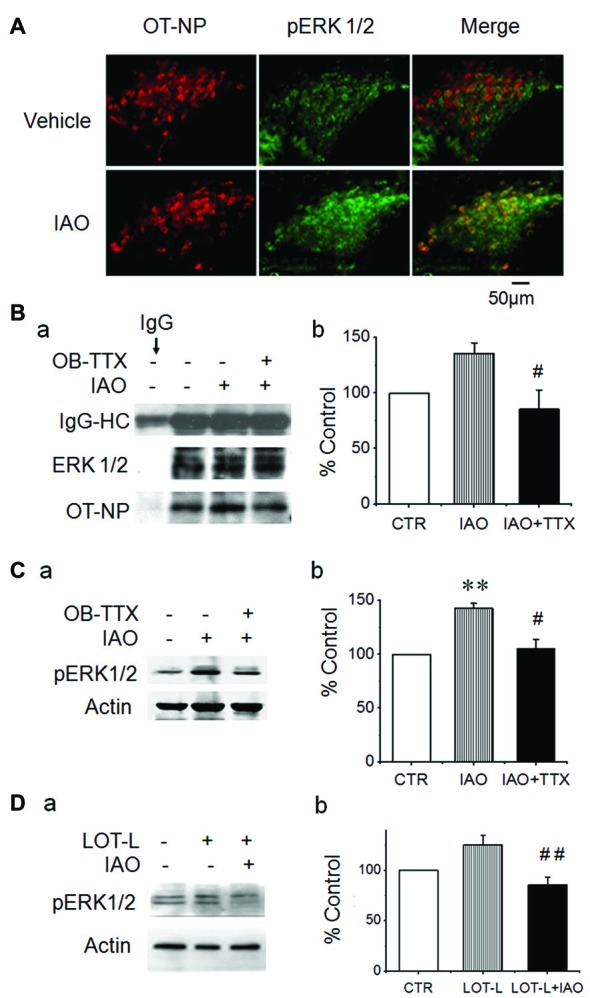
Effects of blocking neural conduction in the OBs and through the lateral olfactory tract (LOT) on nasal OT-elicited pERK 1/2 expressions in the SON. (A) Microscopic images of nasal OT-evoked pERK 1/2 expression in the SON showing (from left to the right) OT-neurophysin (NP), pERK 1/2 and their merge, respectively. (B) Exemplary protein bands (Ba) showing result of co-immunoprecipitation of ERK 1/2 (middle) with OT-NP (bottom) following nasal OT without and with prior intra-OB application of TTX and their summary (Bb). IgG-HC, the heavy chain of immunoglobulin G. (C) Effects of pretreatment of the main OBs with vehicle (Veh., artificial cerebrospinal fluid, aCSF) or TTX (2 μM, 0.5 μl) on nasal OT-evoked pERK 1/2 expressions. Exemplary Western blot bands (Ca) and average levels (Cb, % relative to 10 min of 0.45% saline) of pERK 1/2 in the SON 10 min after nasal OT in rats. (D) Effects of electrolytic lesion of the LOT (LOT-L) on nasal OT-evoked pERK 1/2 expressions. (Da) Exemplary Western blot bands. (Db) Bar graph summarizing the effect of nasal OT without and with LOT lesions based on six rats in each group. **P < 0.01 compared to the control group; #P < 0.05; ##P < 0.01 compared to IAO or the LOT lesion group. Other annotations refer to Figures 1, 2.